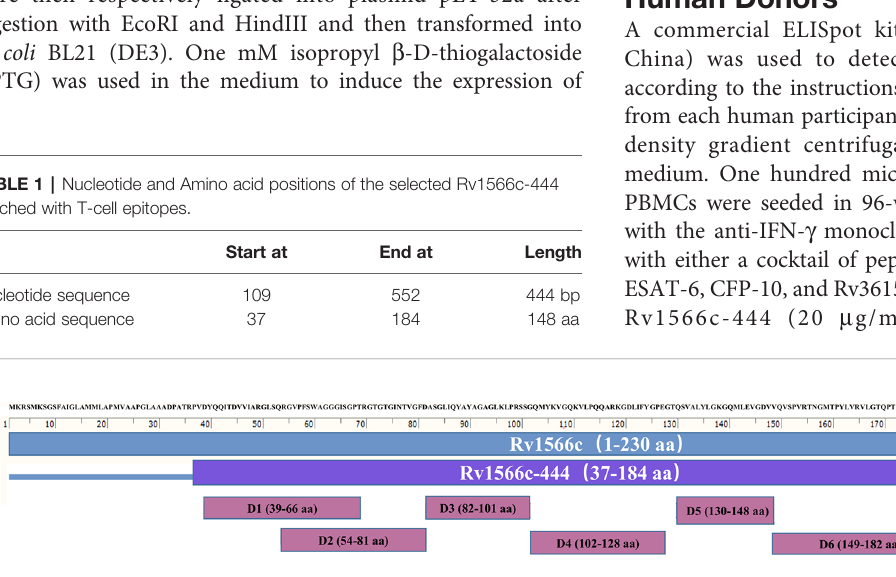
FIGURE 1 | T -Cell epitope-rich domains distributed in Rv1566c. The scale unit is amino acid